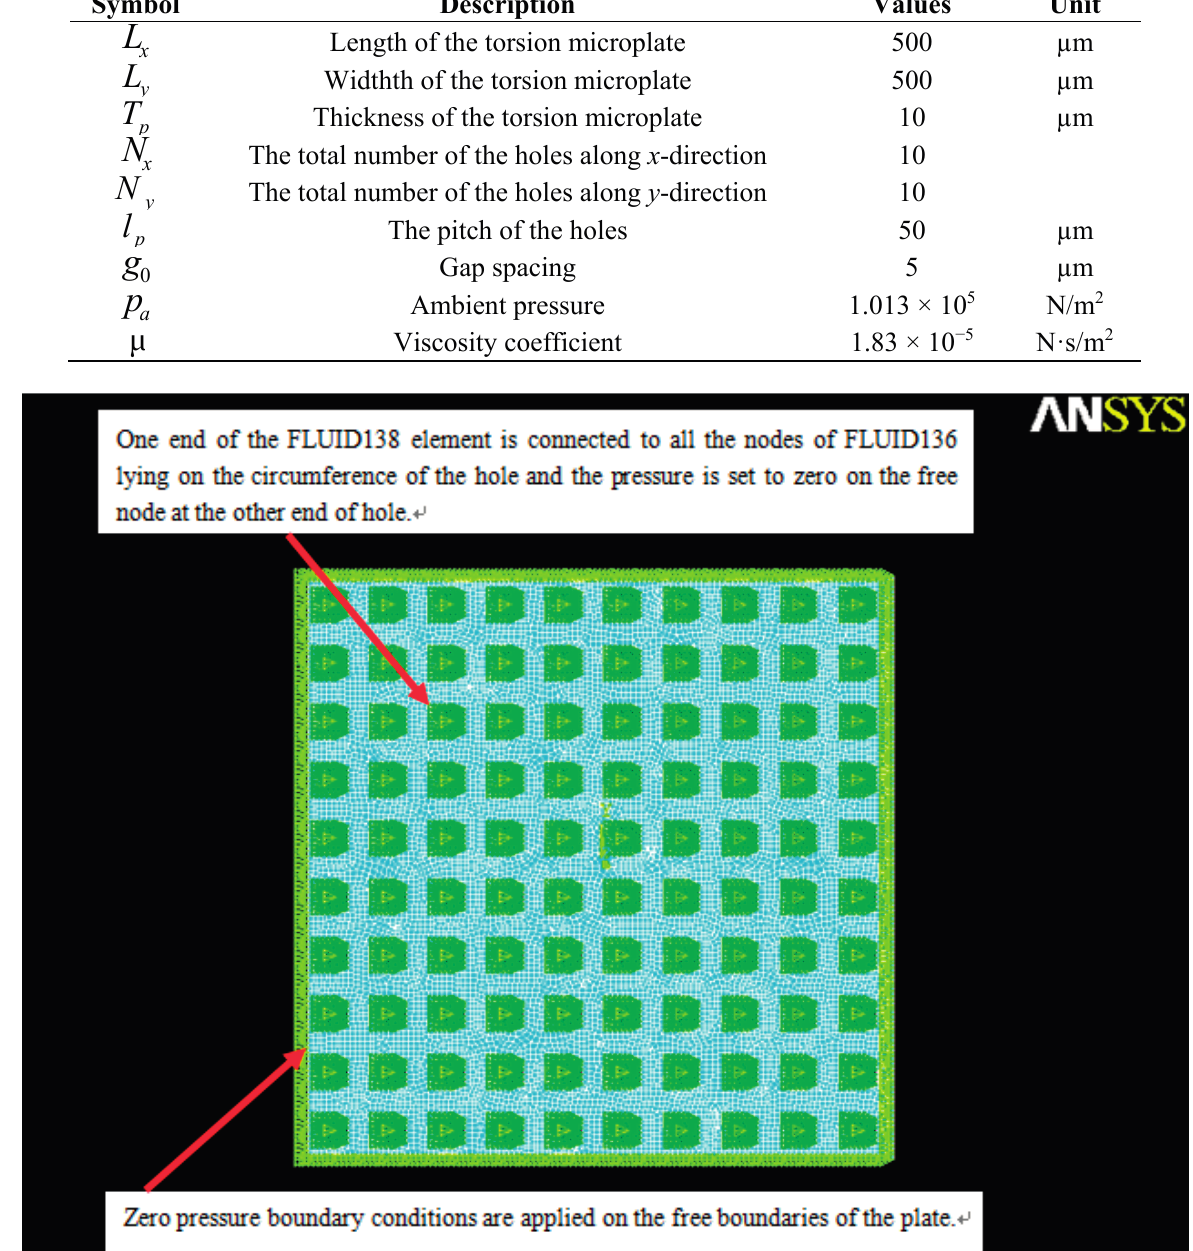
Figure 4. ANSYS model with boundary condition for the perforated micrplate ( l h / l p = 0.4). The infinite summations in the present model for squeeze-film damping were evaluated using MATLAB. Careful convergence studies were